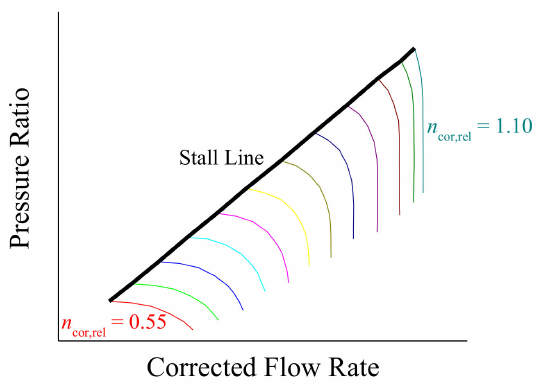
Figure 10. General Component Characteristic Diagram of Front Fan.